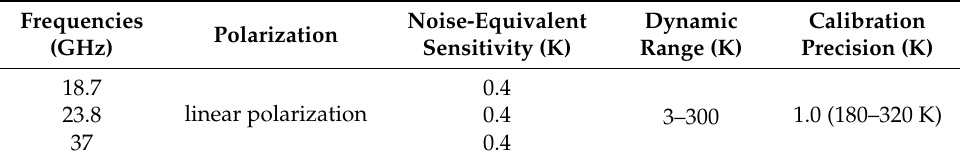
Table 4. The detailed information of the calibration microwave